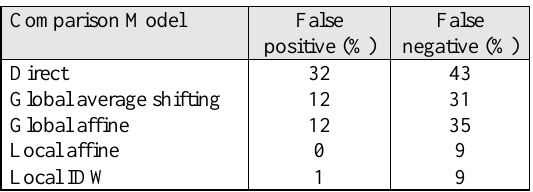
Table 1. Comparison of false positive and false negative errors using all five models in an urban area.